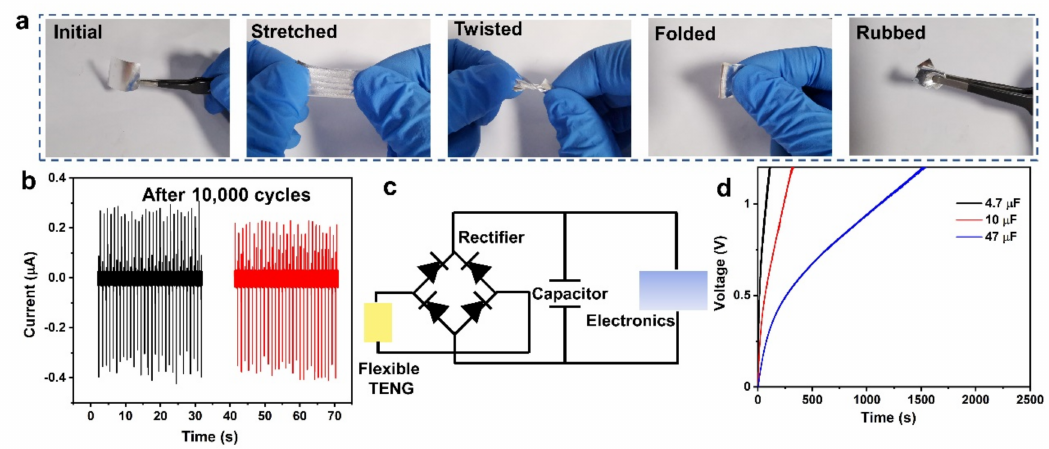
Figure 4. Flexible TENG and its applications. ( a ) The optical images of deformed TENG based on sputtered Ag, including stretched, folded, twisted, and rubbed states; ( b ) The performance of TENG after 10,000 cycles; ( c ) The equivalent circuit of a self-charging system that uses the energy harvested from the TENG; ( d ) Voltage curves of charging capacitors of 4.7 µ F, 10 µ F, and 47 µ